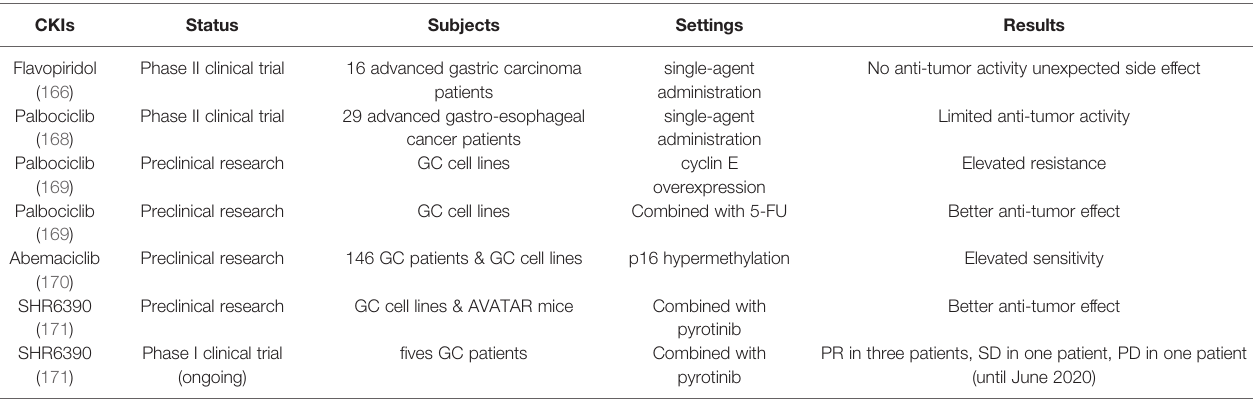
TABLE 2 | CKIs for clinical trials and preclinical studies in